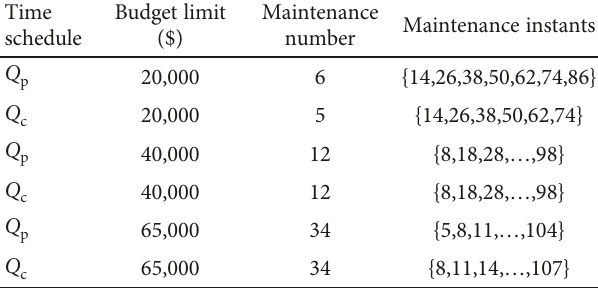
Table 4: Optimal maintenance time